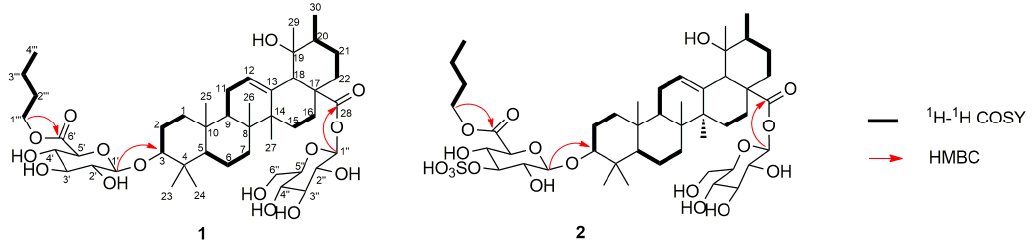
Figure 3. Key 1 H- 1 H COSY and HMBC correlations of 1 and 2 .